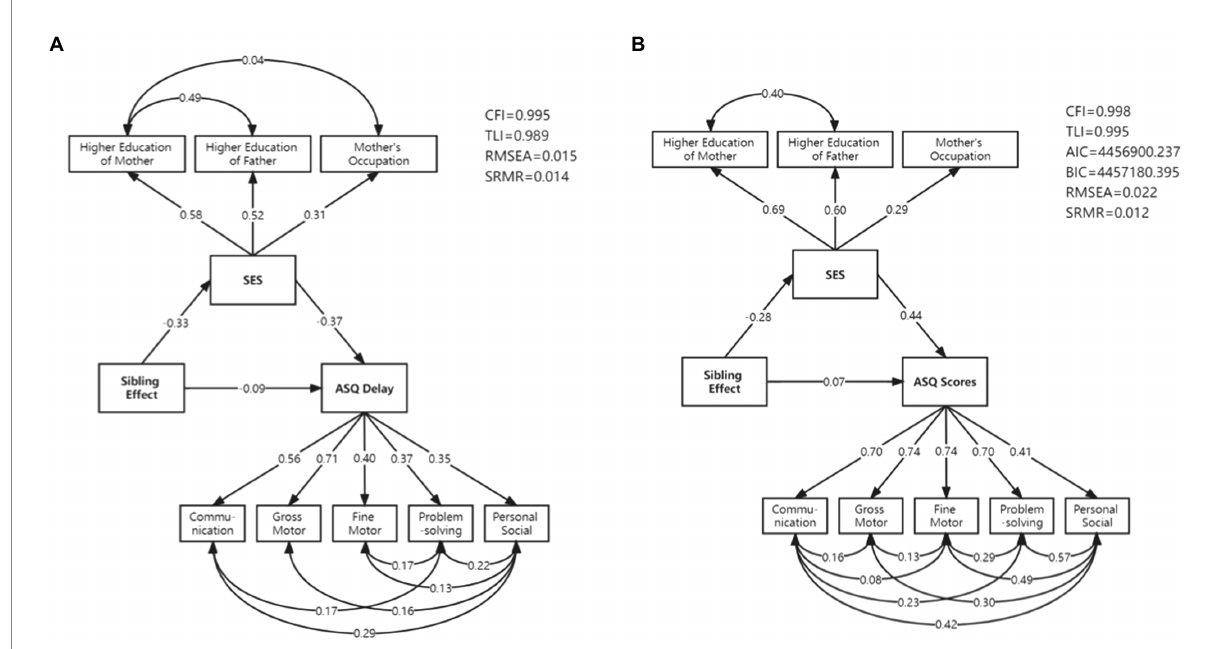
FIGURE 3 The mediation model diagrams: (A) binary outcomes (ASQ delay); (B) continuous outcomes (ASQ